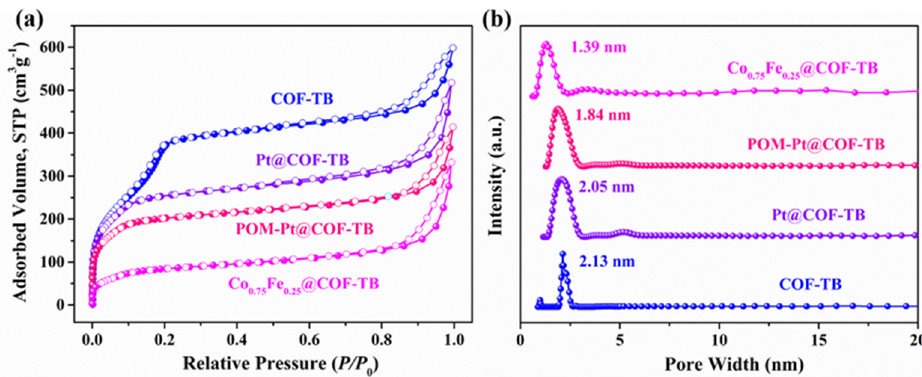
Figure 2. ( a ) Nitrogen adsorption–desorption isotherms of prepared COFs; ( b ) pore size distribution calculated with the NLDFT method. Table 1. Porosity data of prepared porous